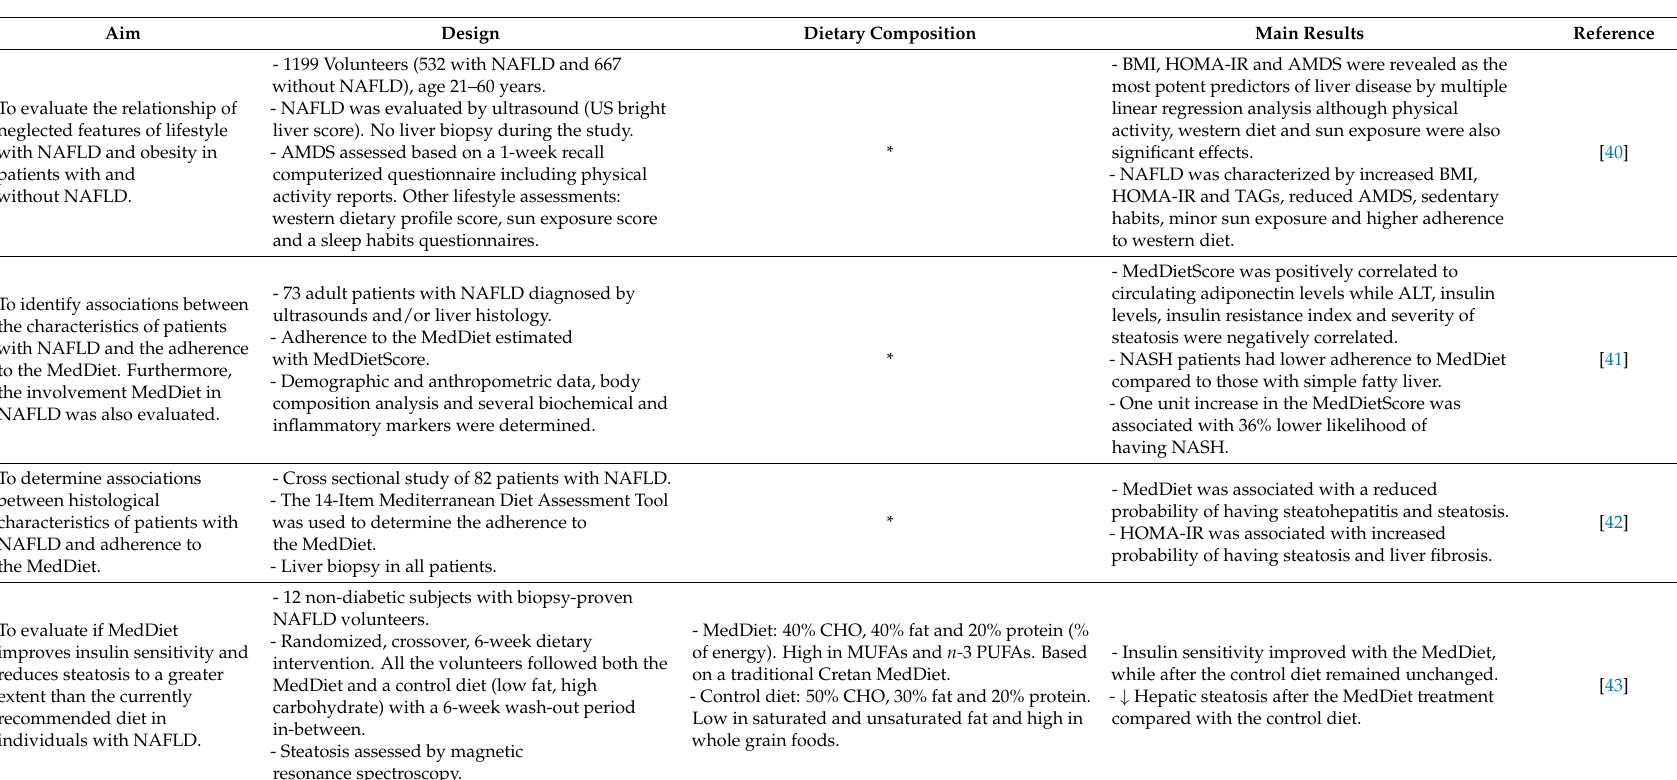
Table 1. Human studies aimed to evaluate the effects of MedDiet against